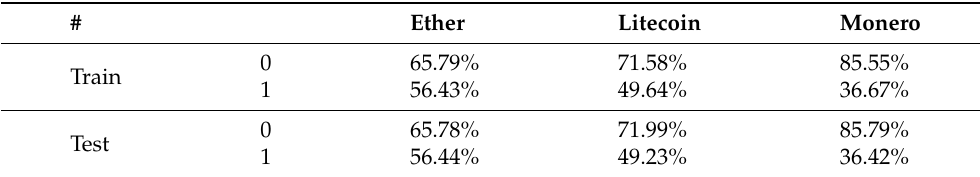
Table 7. Three cryptocurrency breakdown pattern